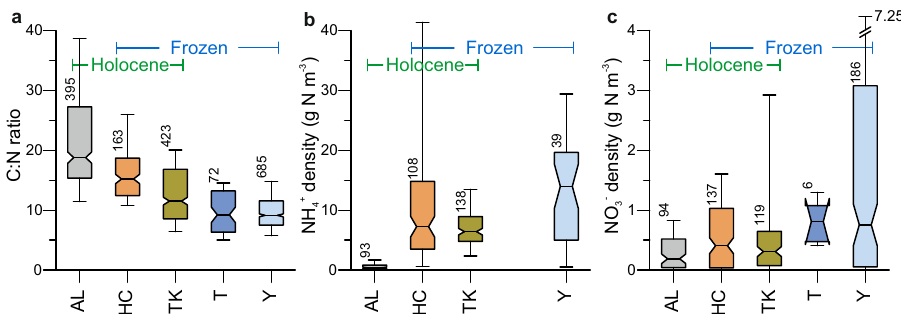
Fig.4|Nbiovailabilityindicators. TheC:Nratio( a ),NH 4 + ( b )and NO 3 − ( c )density of the different stratigraphic units. Whiskers show the 10/90 quantiles, the boxes are bordered by the 1st and 3rd quartiles, including the median with notches (95% con fi denceintervalaroundthemedian).Thenumbersabovethewhiskersshowthe